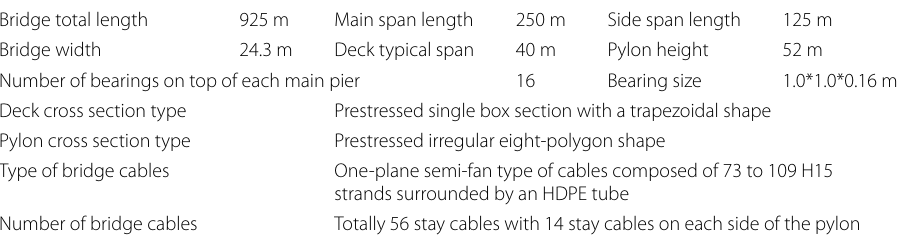
Table 3 General description of the bridge Bridge total